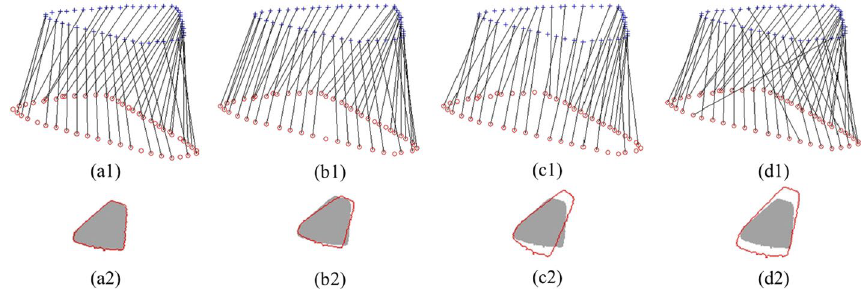
Fig. 7 The matching results between the No. 7 water region in the template image (blue plus sign) and the No. 2 water region in the input image (red cycle) using a AICT-DOPM, b SC, c ICP and d TPS-RPM